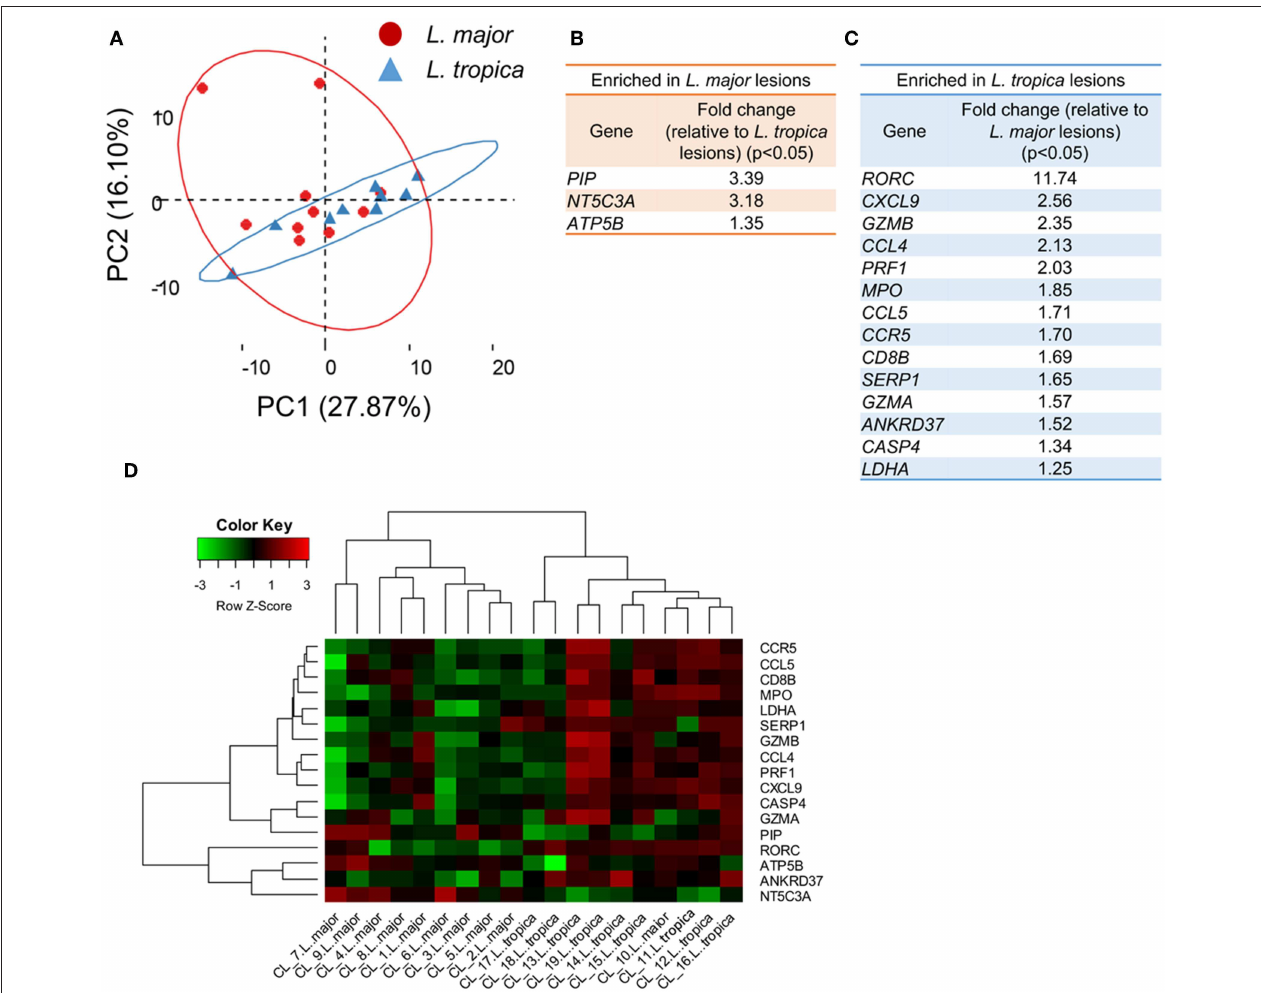
FIGURE 3 | Skin biopsies from CL patients caused by L. major or L. tropica are transcriptionally very similar, the latter presenting an aggravated inflammatory/cytotoxic signature. (A) PCA analysis of the 170 analyzed genes from the 19 CL skin biopsies caused by infection with either L. major (red dots) or L. tropica (blue triangles). The two principal components (PC) are displayed on the axis along with the variance. Large circles denote the 95% confidence level. (B) Table detailing the genes significantly ( P < 0.05) enriched in L. major biopsies as compared with L. tropica . (C) Table detailing the genes significantly ( P < 0.05) enriched in L. tropica biopsies as compared with L. major . (D) Clustered heatmap of skin biopsies from CL patients according to their expression of the genes differentially expressed between L. major and L. tropica